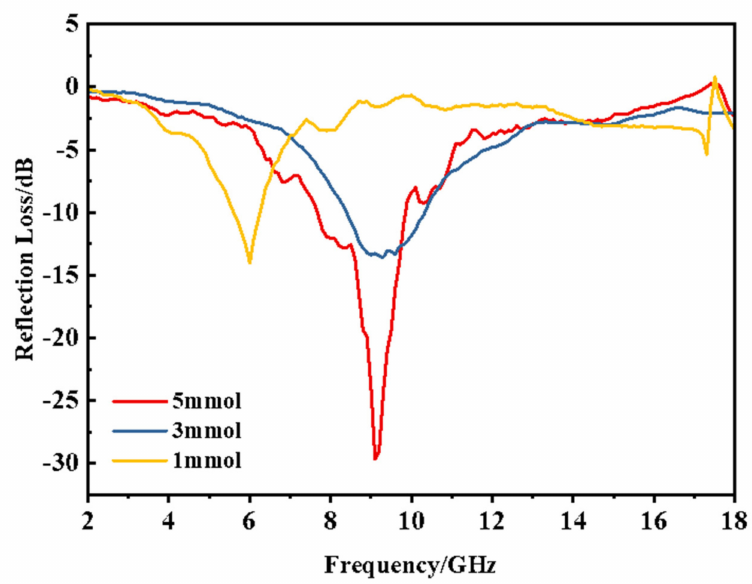
Figure 8. Reflection loss diagram of Fe 3 O 4 /MWCNT heterostructure with different Fe 3+